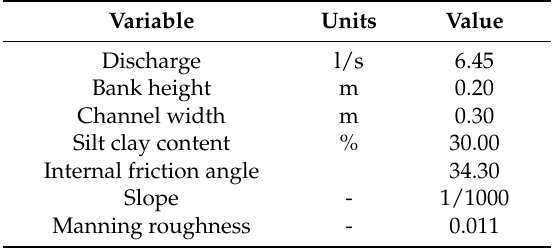
Figure 4. Initial cross section for the simulations. Table 1. Numerical conditions for the simulations.